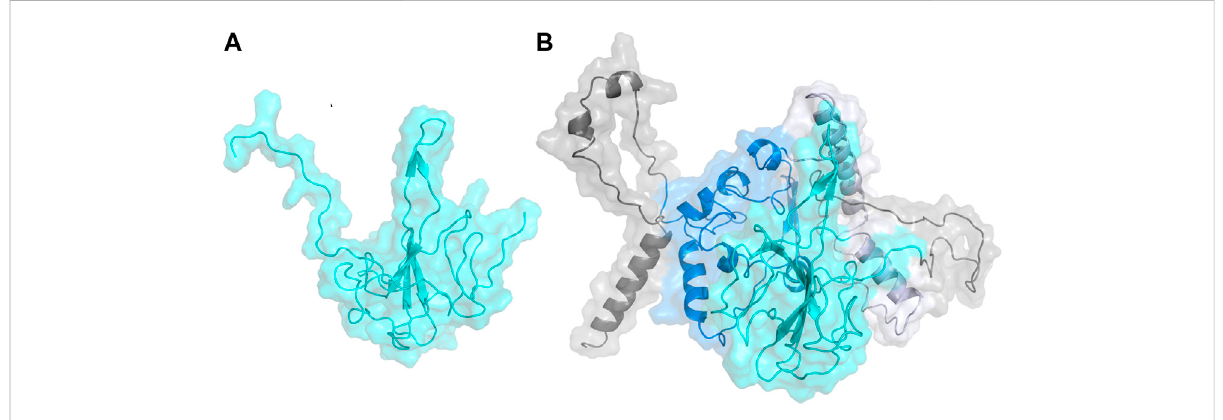
FIGURE 1 (A) Homology model built on YASARA for N-terminal domain of the Nucleocapsid protein shown in cyan. (B) Homology model built on I-TASSER for the full length Nucleocapsid protein with domains colored as: N-terminal domain — cyan; C-terminal domain — blue; linker region — lavender; other regions — gray.